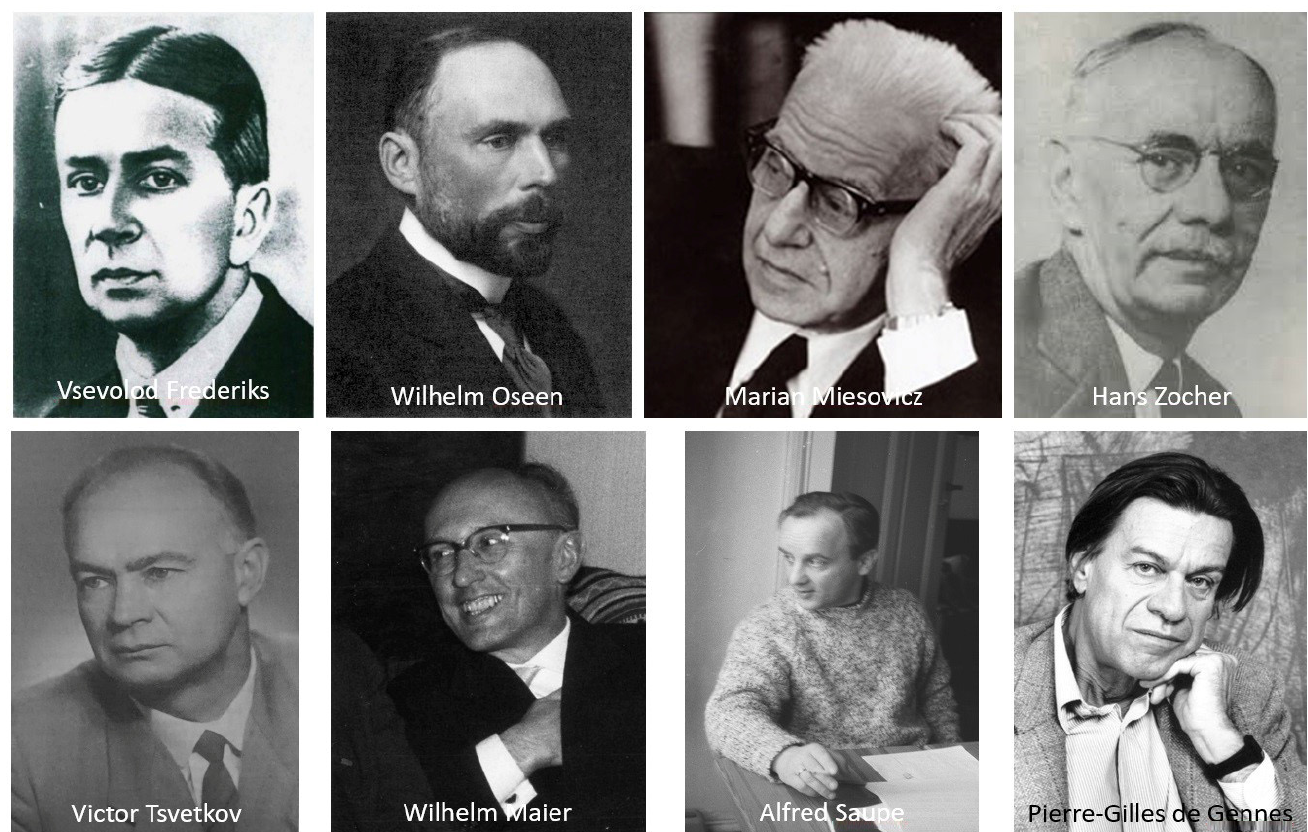
Figure 3. Pioneering international liquid crystal scientists before the display era: Fredericks (Russia), Oseen (Sweden), Miesowicz (Poland), Zocher (Germany, Brazil), Tsvetkov (Russia), Maier and Saupe (Germany), and de Gennes (France).